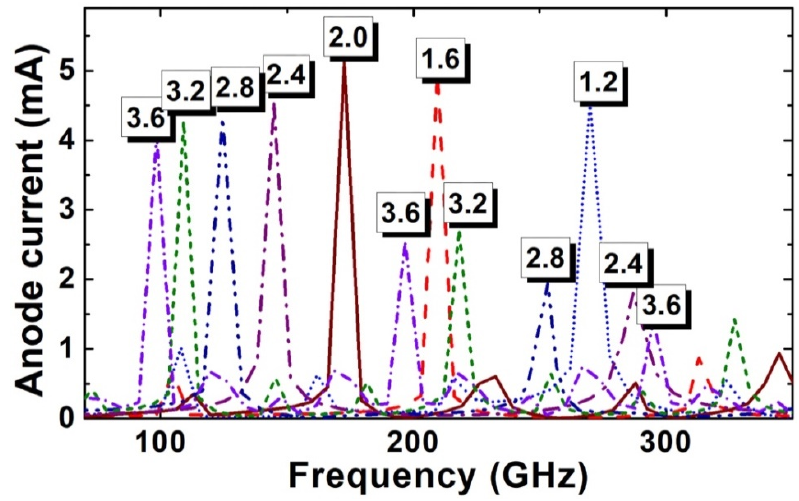
Figure 9. The frequency spectrum diagram of the grooved-anode diode for different L.